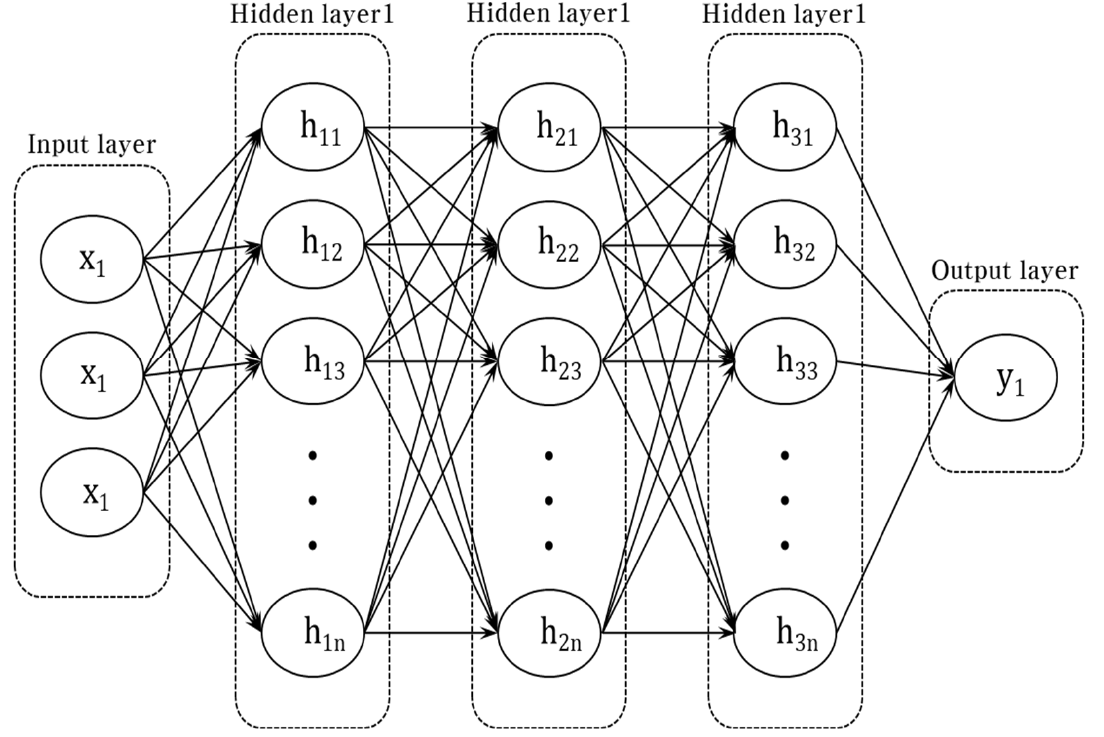
Figure 2. MLP architecture